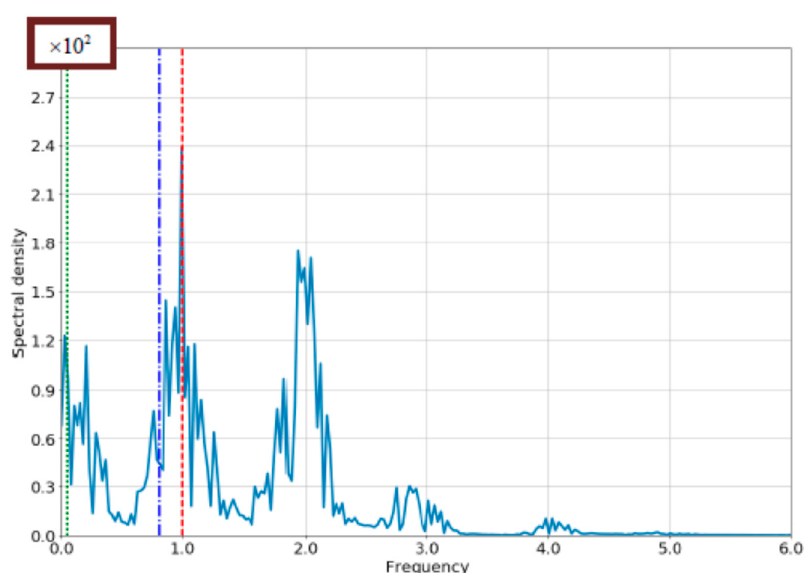
Figure 9. Frequency spectrum of the dipole moment with RO and BO in the separated frequency ranges at the atom with position number j = 90. All parameters are identical to Figure 3.